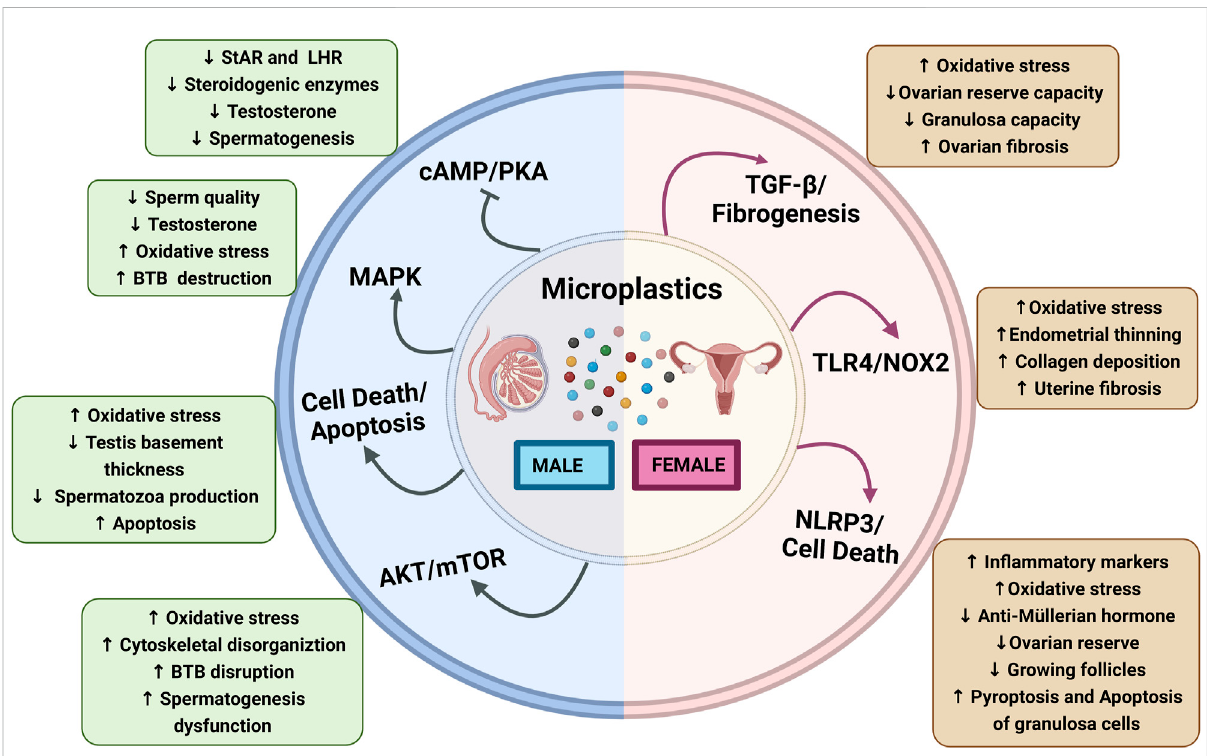
FIGURE 1 Schematic diagram showing microplastics affecting male and female reproductive functions: Microplastics affecting male reproductive functions via the activation of different signaling pathways, Akt/mTOR, apoptosis, MAPK, and inhibition of cAMP/PK3 that results in increased oxidative stress, BTB disruption, and spermatogenesis dysfunction and decrease in steroidogenic enzymes and LHR downregulation. Microplastics affecting the female reproductive functions altered by the activation of NLRP3, TLR4/NOX2, and TGF- β / fi brogenesis that results in increased oxidative stress, endometrial thinning, collagen deposition, in fl ammatory markers, and pyroptosis and apoptosis of granulosa cells while ovarian reserve, growing follicles, granulosa cells capacity, and anti-müllerian hormone levels are decreased. Abbreviations: cAMP, cyclic adenosine monophosphate; AKT, Ak strain transforming; BTB, blood – testes barrier; LHR, luteinizing hormone receptor; MAPK, mitogen-activated protein kinase;mTOR,mammaliantargetofrapamycin;NOX-2,NADPHoxidase-2;NLRP3,nod-likereceptorfamilypyrindomaincontaining3;PKA,protein kinase A; StAR, steroidogenic acute regulatory protein; TGF- β , transforming growth factor- β ; TLR4, toll-like